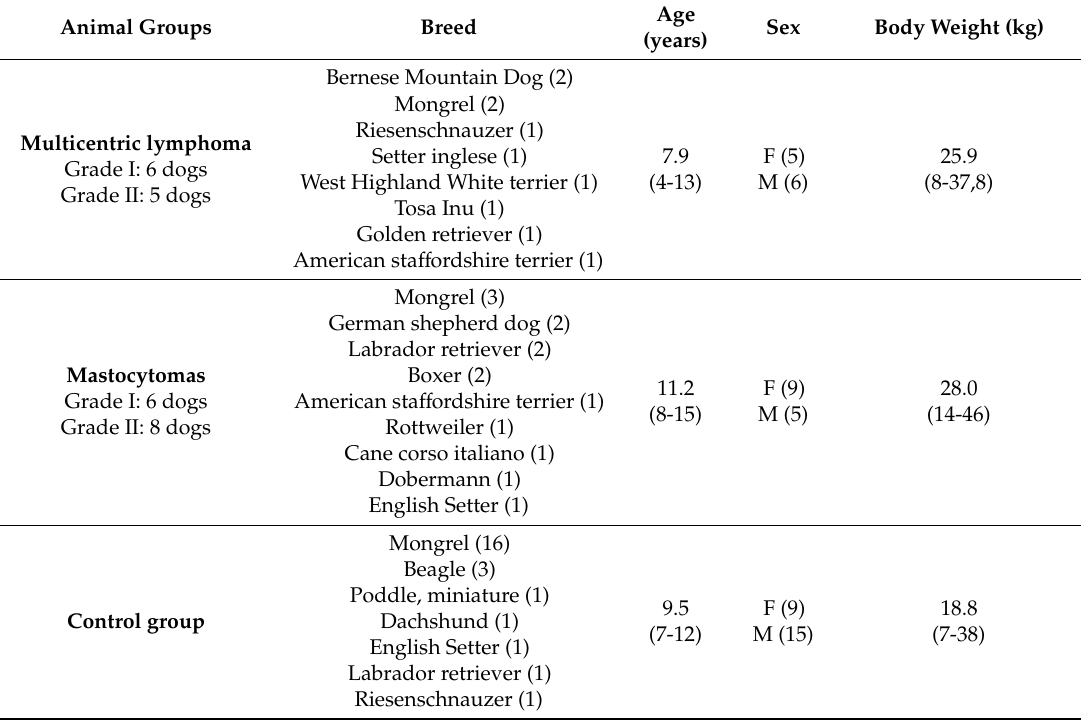
Table 1. Animals used in this study: number, breed, sex, age and body weight. Animal